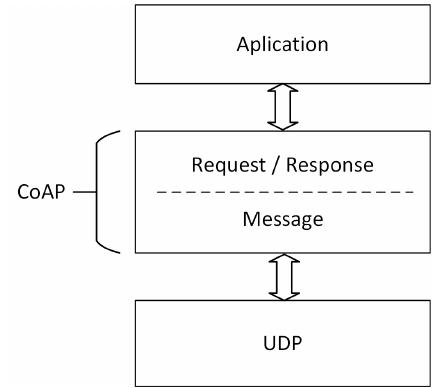
Figure 1. Simplified layered stack of Constrained Application Protocol (CoAP) (adapted from